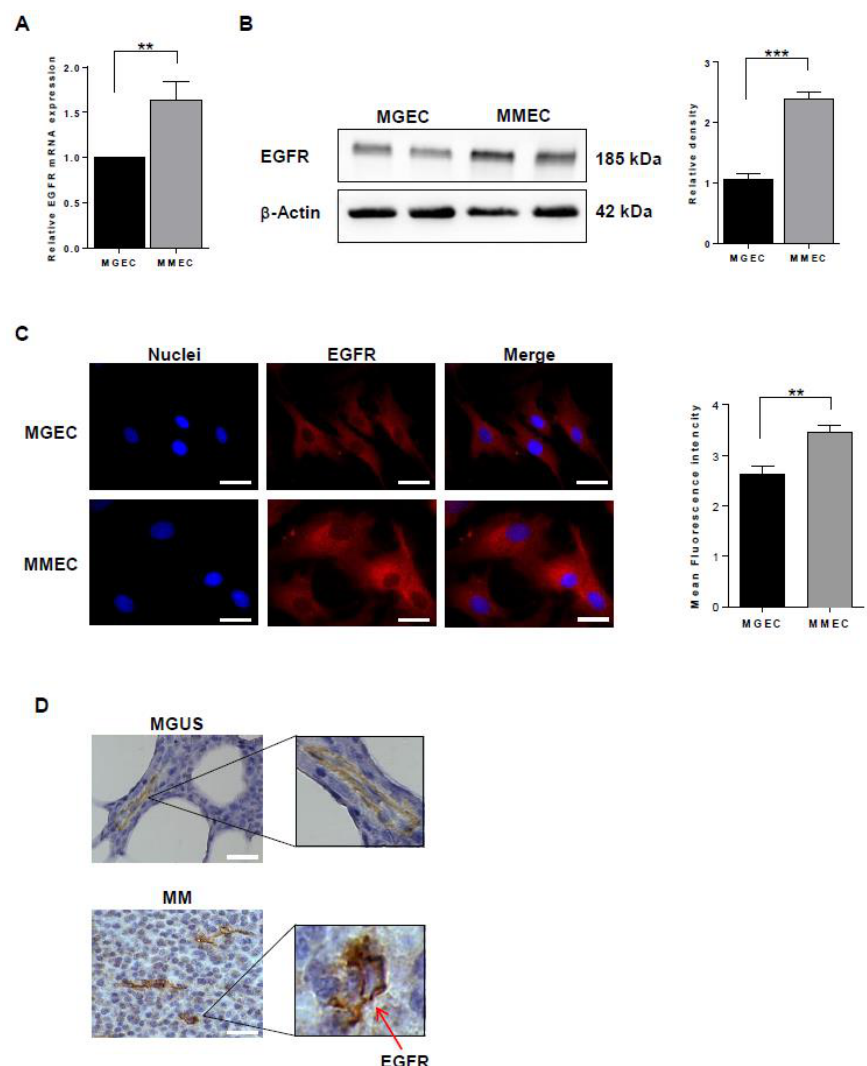
Figure 1. EGFR expression is higher in bone marrow endothelial cells from MM than MGUS patients. ( A ) Relative mRNA levels of epidermal growth factor receptor (EGFR) in endothelial cells from MGUS and MM patients (MGEC and MMEC, respectively), determined by real time-PCR. Samples from six MGUS and six MM patients were tested in triplicate. Data are expressed as mean and SD. ( B ) Western blot of EGFR (using a rabbit anti-human antibody) and β -actin in whole cell lysates of MGEC and MMEC ( left ) and results of densitometric analysis, with EGFR values normalized first to β -actin and then to MGEC values ( right ). Samples from eight MGUS and eight MM patients were tested in triplicate. Values are expressed as mean and SD. ( C ) Immunofluorescence staining of EGFR (using a rabbit anti-human antibody; red) on cultured MGEC and MMEC ( left ) and quantification analysis ( right ). DAPI (blue) was used to stain nuclei. Control experiments without the primary antibody (omitted) showed no background staining. Representative photomicrographs of four independent experiments are shown. Original magnification 400× . Scale bar, 25 μm. The quantification of the immunofluorescence was performed by ImageJ software. ( D ) Immunohistochemical detection of EGFR (pink) on CD31-positive cells (brown) in bone marrow vessel walls from MGUS and MM patients. The images were analyzed by two independent pathologists in a blind fashion. Representative photomicrographs of four independent experiments are shown. Original magnification 400× . Scale bar, 25 μm. ** p < 0.01 and *** p < 0.001, Mann – Whitney U test.